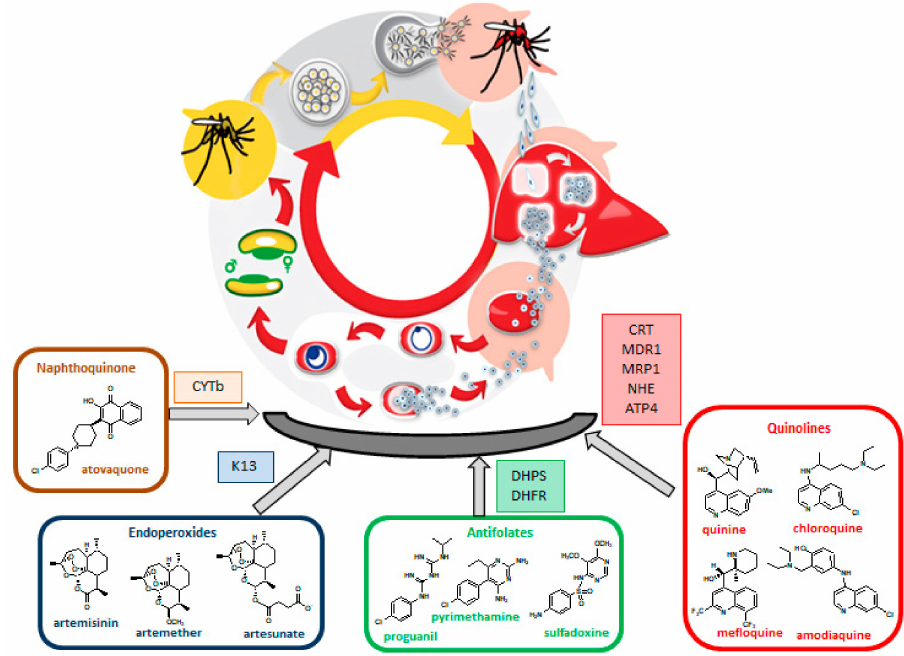
Figure 1. The major classes of antimalarials and the corresponding target mutations responsible for resistance. (CYTb—Cytochrome b; K13—kelch 13 protein; DHPS—dihydropteroate synthetase; DHFR—dihydrofolate reductase; CRT—chloroquine resistance transporter; MDR1—multidrug resistance protein 1; MRP1—multidrug resistance-associated protein 1; NHE—Na + / H +